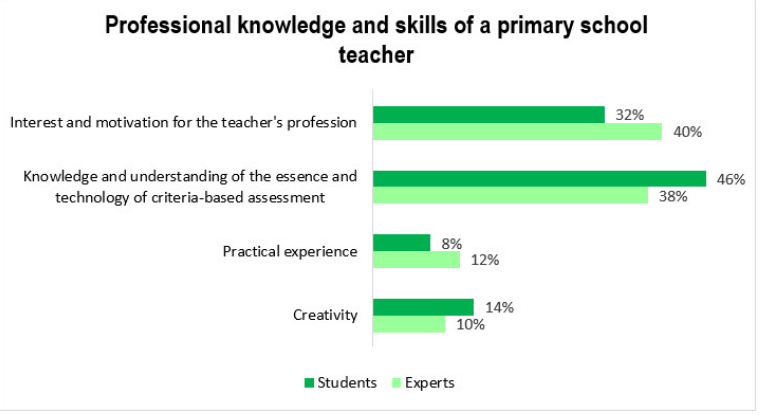
Figure 6. Teaching in the updated